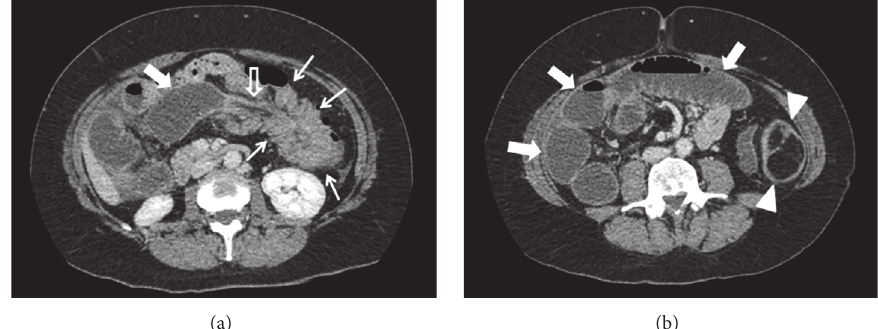
Figure 1: Contrast-enhanced CT, portal venous phase, axial images. In (a) the last ileal loop is dilated (full arrow); a part of the right colon and its mesentery (empty arrow) are recognizable inside the left colon (thin arrows). In (b) the section is at a lower level; on the left side, the colonic lipoma (arrowheads) is recognizable as a lobulated lesion with fat-equivalent density and with inner septa. On the right side notice dilated small bowel loops (full arrows) and absence of the right colon.